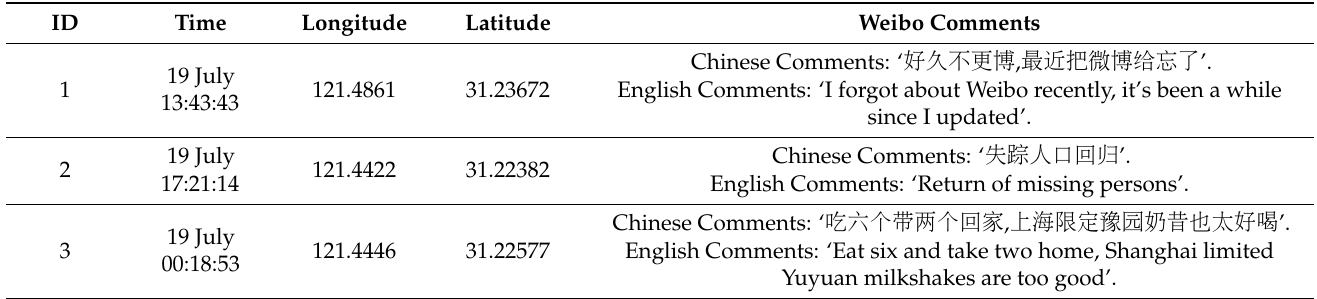
Table 2. Example of Weibo comments.